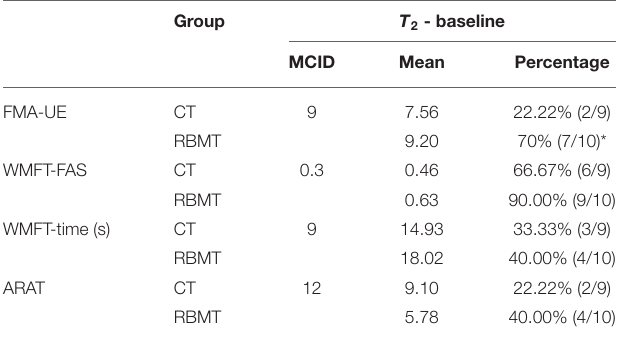
TABLE 3 | Comparison of intervention effects to the minimal clinically important difference (MCID) in the Fugl–Meyer assessment of the upper extremity